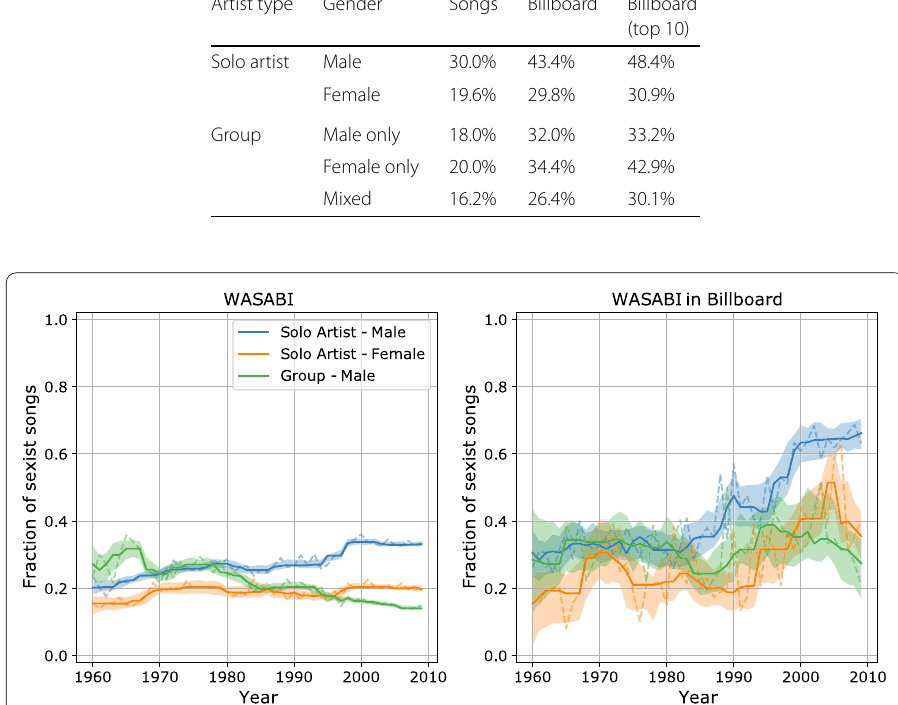
Figure 3 Fraction of songs containing sexist content. Colors refer to different artist type and gender. Dashed lines are the raw fractions of songs, and solid lines with 95% confidence intervals were obtained using a median filter with a window equal to 5